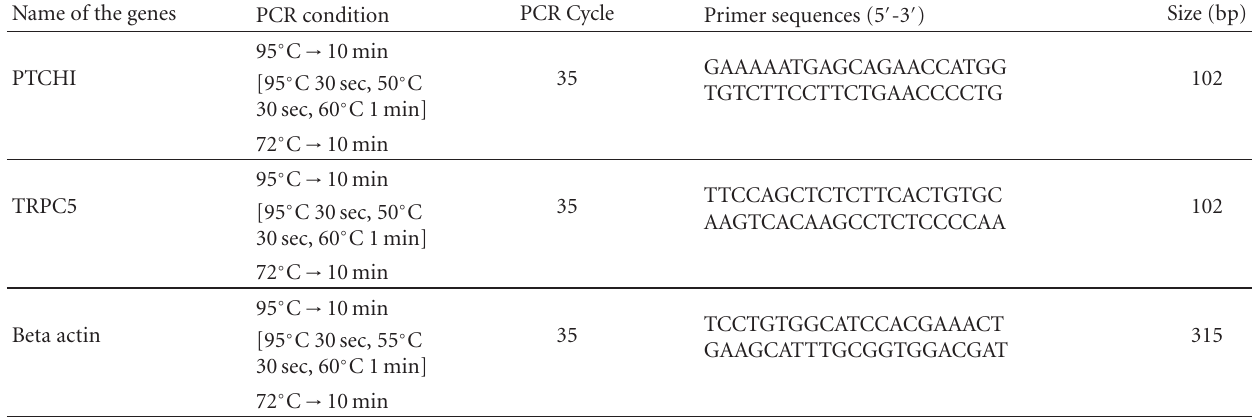
Table 1: Primer sequences and PCR conditions of real-time